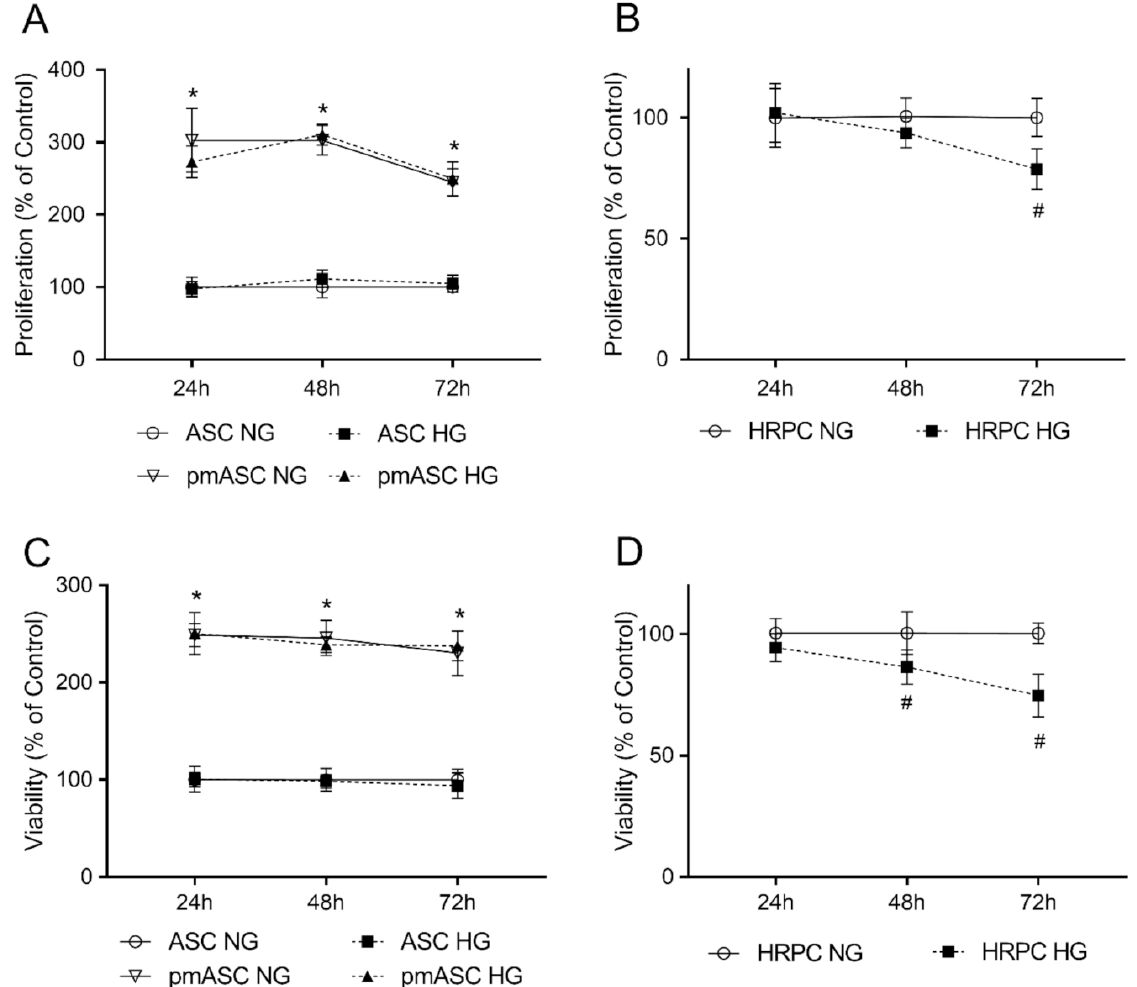
Figure 2. High glucose effects on cell proliferation and viability in human adipose mesenchymal stem cells cultured in basal medium (ASC) or in pericyte medium (pmASC), and in human retinal pericytes (HRPC). In some samples, glucose was added to the culture medium (High Glucose, 25 mM, HG); data were gathered after 24 h, 48 h and 72 h from glucose addition and compared to corresponding samples kept in normal glucose (NG) condition. Proliferation rate was assessed by crystal violet assays in ASC, pmASC ( A ), and HRPC cultures ( B ) in NG or in HG. Cell viability was evaluated by MTT assays in ASC, pmASC ( C ), and HRPC cultures ( D ) in NG or in HG. Absorbance values were determined at 570 nm for both assays. Values are expressed as mean ± SEM of three independent experiments. In A and C, values are referred to ASC NG population, at each corresponding time point. In B and D, values are referred to HRPC NG population, at each corresponding time point. * p < 0.05 pmASC vs. ASC; # p < 0.05 HG vs. NG. Two-way ANOVA, followed by Sidak’s